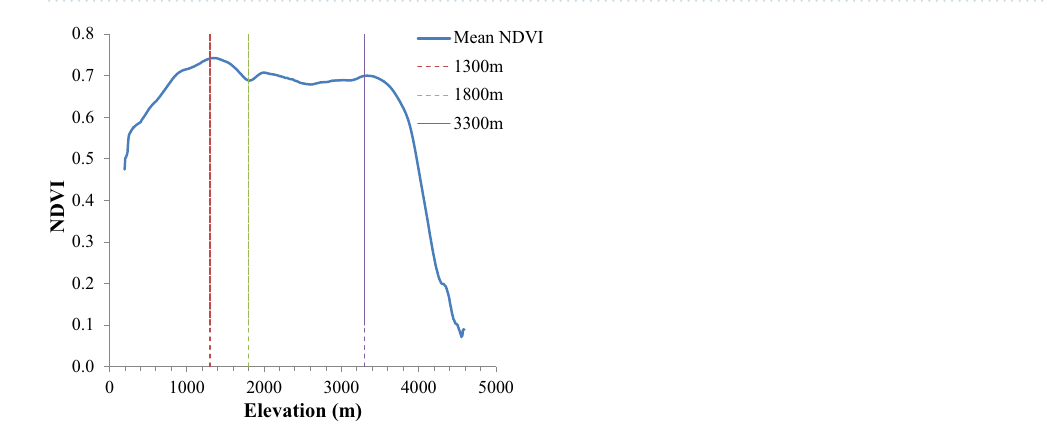
Figure 3. The NDVI change under different elevation in Qin Mountains (1987–2018). Statistics the NDVI value for every pixel in DEM image, and then used the Exponential Smoothing method in Excel to simplify the curve.